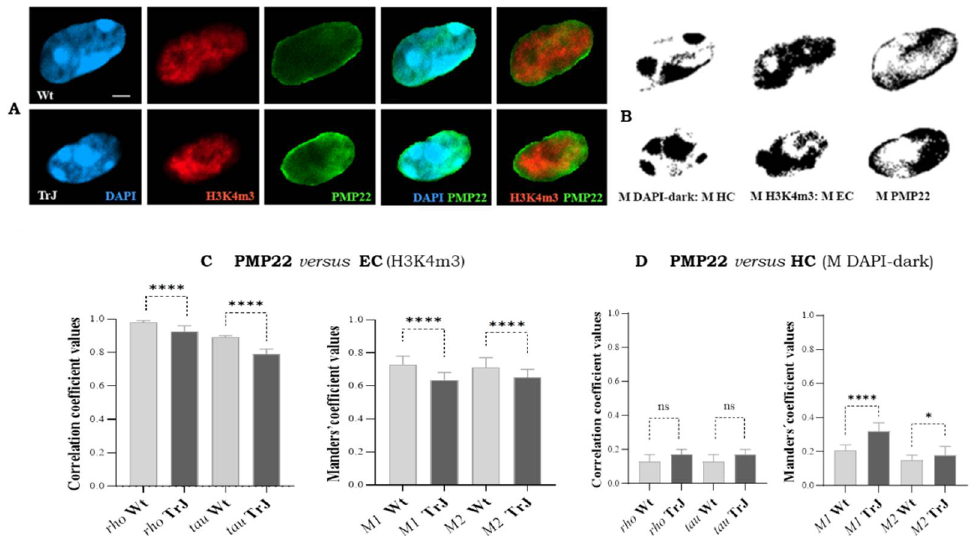
Figure 6. Colocalization analysis of PMP22 with euchromatin and heterochromatin in Schwann cell nuclei. ( A ): Images of Wt and TrJ SC nuclei showing DAPI (blue), euchromtic H3K4m3 (red) and PMP22 (green) signals. ( B ): Respectively mask images of heterochromatin (M HC), euchromatin (M EC) and PMP22 (M PMP22, obtained using the threshold tool of Fiji. ( C ): Colocalization analysis between PMP22 (PMP22 signal) and euchromatin (H3K4m3 signal). M1: fraction of euchromatin in PMP22 area, and M2 : fraction of PMP22 area in euchromatin. ( D ): Colocalization analysis between PMP22 (PMP22 signal) and heterochromatin (M HC). M1 : fraction of heterochromatin in PMP22 area, and M2: fraction of PMP22 area in heterochromatin. ( B , C ): Bar diagrams representing, by means of median and 95% confidence intervals, the distributions of rho and tau correlations and M1 and M2 co-occurrence coefficients, respectively. Rho , tau , M1 and M2 were obtained employing Fiji Coloc 2 plugins with Costes p -values > 95%. The bar diagrams represent the medians and 95% confidence intervals of the coefficients. Differences between Wt and TrJ were analyzed applying Mann– Whitney tests ( p -values : * < 0.01 and **** < 0.0001) in 100 SC nuclei per genotype. Scale bar = 2µm. Correlations and co-occurrence coefficient values denote that PMP22 colocalize with EC and much lesser with HC in both Wt and TrJ SC nuclei. However, there is more colocalization with EC in Wt and more colocalization with HC in TrJ.